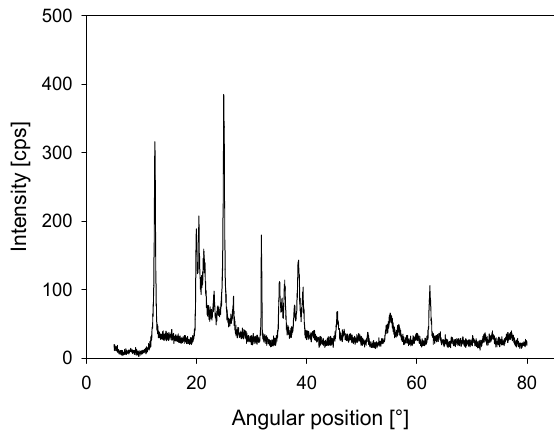
Figure 1. X-ray diffraction (XRD) for kaolin powder.